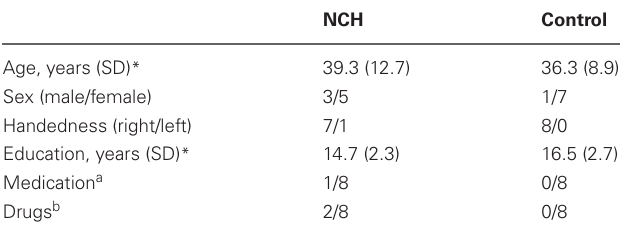
Table 1 | Demographic characteristics of the non-clinical hallucinator (NCH) and non-hallucinating non-clinical control